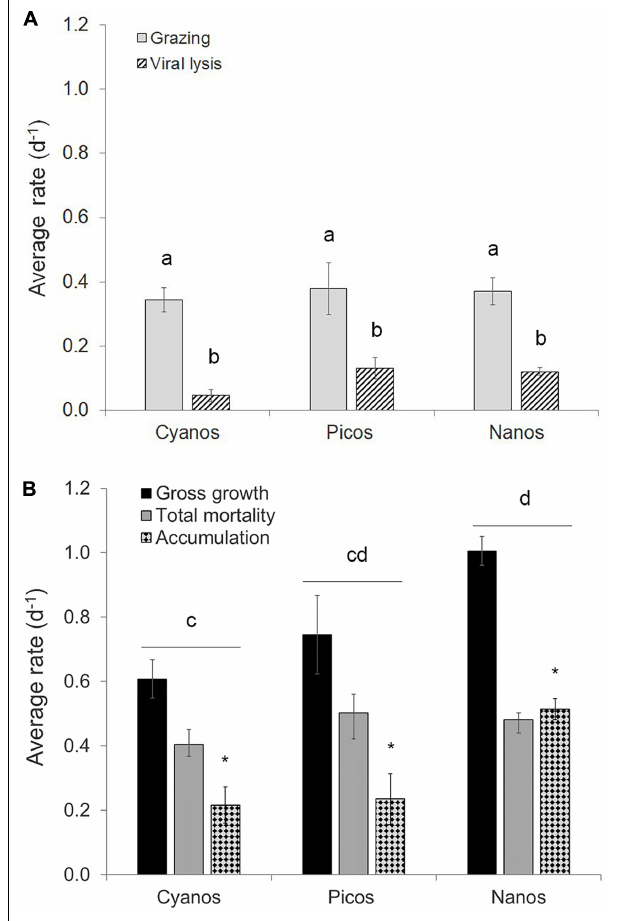
FIGURE 4 | Average rates of division and loss obtained from the modified dilution method for cyanobacteria, and pico- and nano-eukaryotic phytoplankton groups. (A) Grazing and viral lysis rates. (B) Gross division, total mortality (i.e., grazing and viral lysis), and accumulation rates of the different phytoplankton groups. The different phytoplankton groups include cyanobacteria (cyanos, sample size N = 12), picoeukaryotes (picos, N = 10), and Nano I ( N = 17). Error bars represent standard error. In each panel, bars with different letters are significantly different ( p < 0.05), as tested by two-way analysis of variance. In panel B, line and associated letter represent the results of post hoc comparison of the means using Tukey’s honest significant difference. The asterisks represent the significance of the positive accumulation rates as revealed by two-way